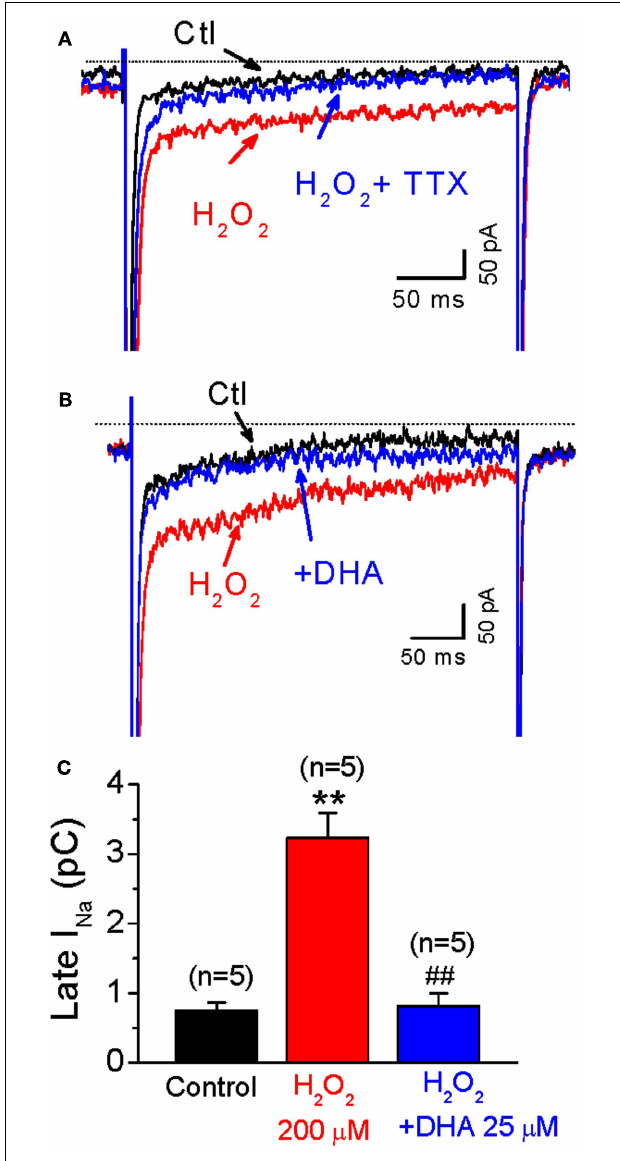
FIGURE 3 | Inhibitory effects of DHA on late I Na enhanced by H 2 O 2 . (A) Representative I Na traces under control condition (Ctl), in the presence of 200 µ M H 2 O, and H 2 O 2 + TTX (10 µ M), respectively. (B) Representative I Na traces under control condition (Ctl), in the presence of 200 µ M H 2 O, and H 2 O 2 + DHA (25 µ M), respectively. (C) A bar graph summarizing 200 µ M H 2 O 2 -induced increase of late I Na , which is significantly suppressed by 25 µ M DHA. ** p < 0.01 vs. control; ## p < 0.01 vs. H 2 O 2 group.